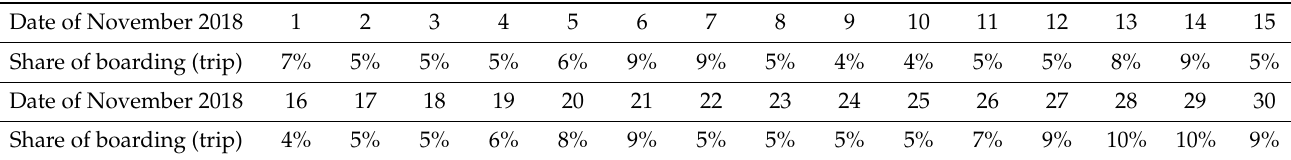
Table A4. Distribution of share of boarding over a